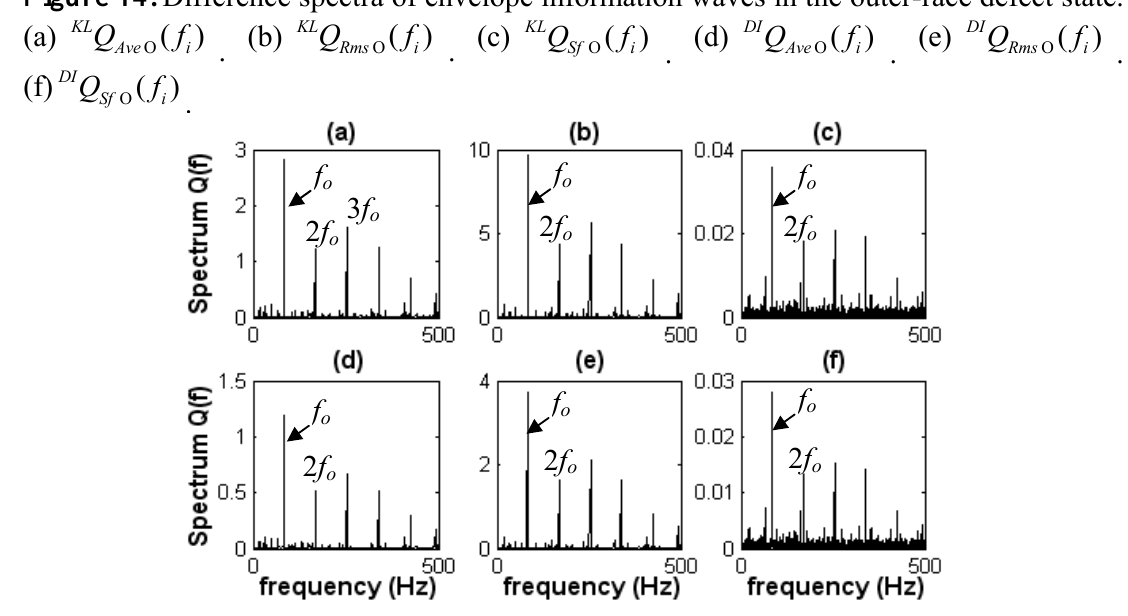
Figure 14. Difference spectra of envelope information waves in the outer-race defect